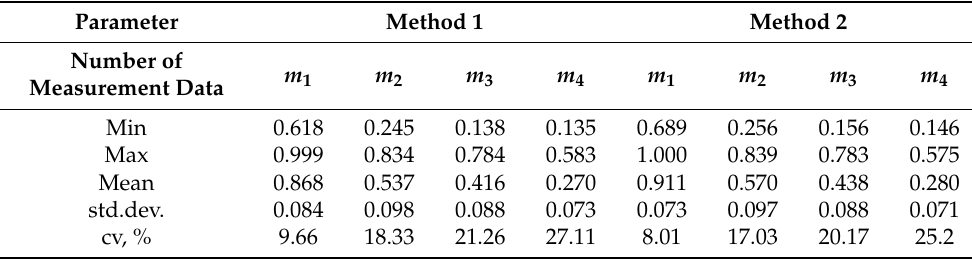
Table 6. Ratio Je / Jm characterizing the state estimation for load level V 1.5 .